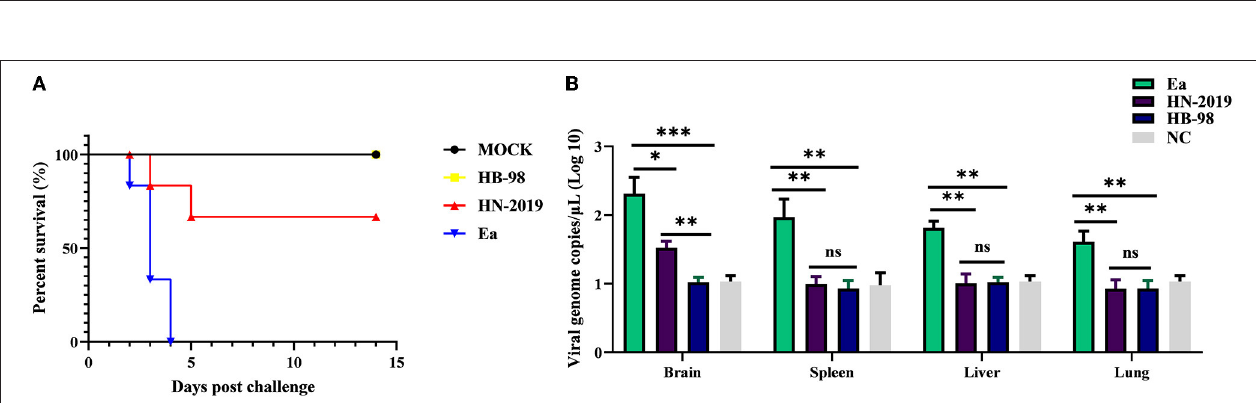
FIGURE 2 | Detection of the PRV gE , gG, or TK genes by PCR. Wild PRV (Ea) strain and HN-2019 strain genomes were extracted and their gE , gG, and TK genes were amplified by PCR using three pairs of primers. The altered size of the PRV TK gene of HN-2019 (A) . Nucleotide sequence alignment of the TK genes of JX/CH/2016, HN-2019, Ea, and HB-98 vaccine strains (B) . Phylogenetic trees based on the gE , TK, or gG nucleotide sequences were generated using MEGA7 software with the ML method [time-reversible (GTR) model; 1,000 bootstrap replicates] (C–E) .